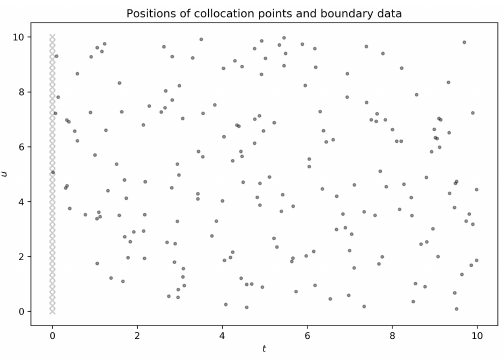
Figure 3. The randomly selected data points used to construct the training data